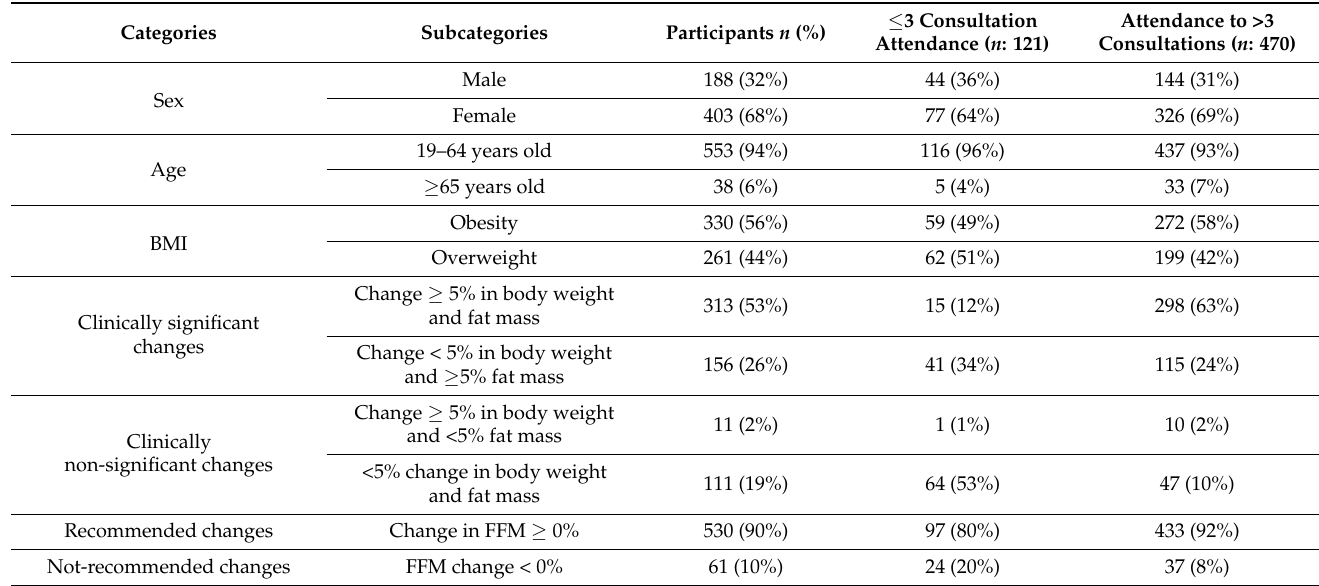
Table 1. Percentage of subjects exposed to dietary intervention ( n :